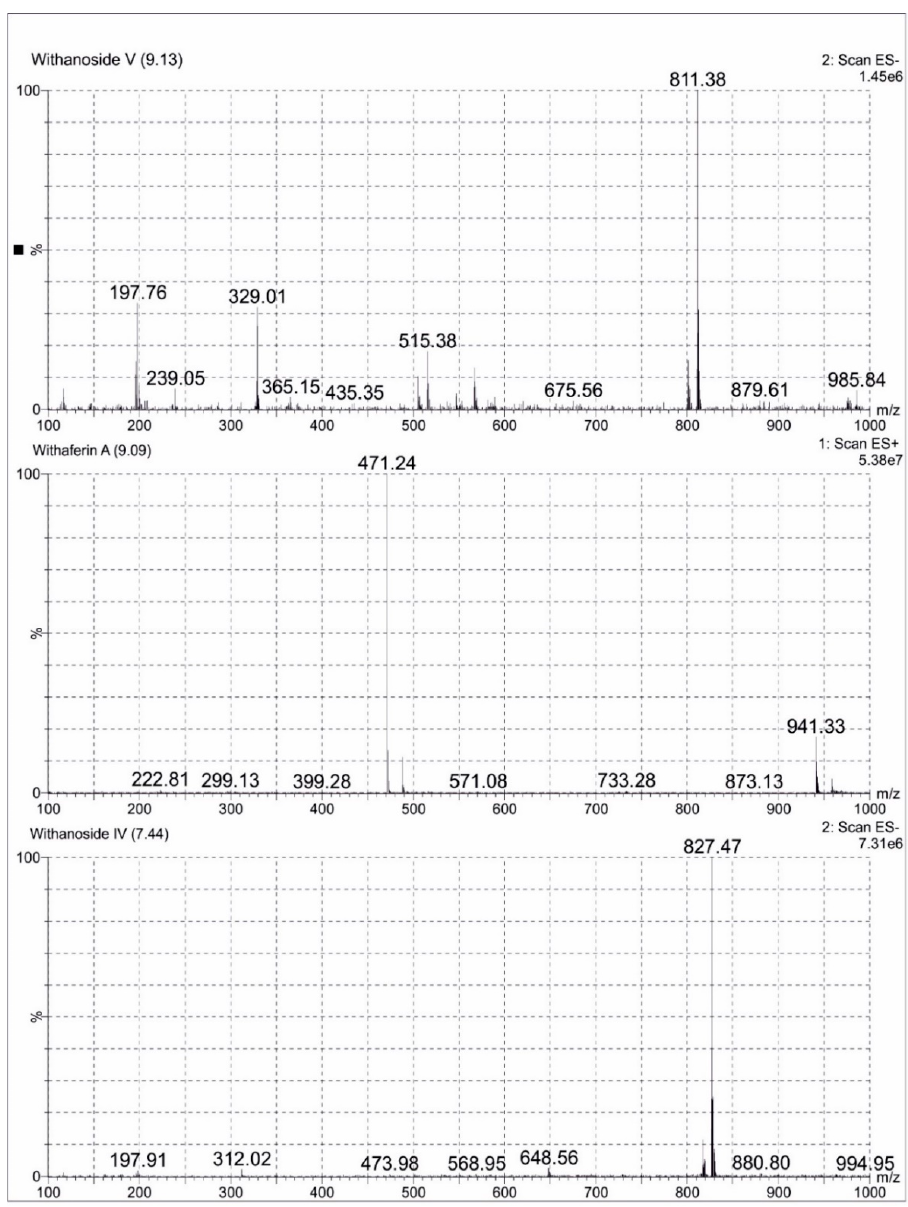
Figure 1. Negative and Positive ion electrospray ionisation liquid chromatography -mass spectrometry mass spectrum (ESI-MS) of Withanoside V, Withaferin A and Withanoside IV separated in Ashwagandha extract.